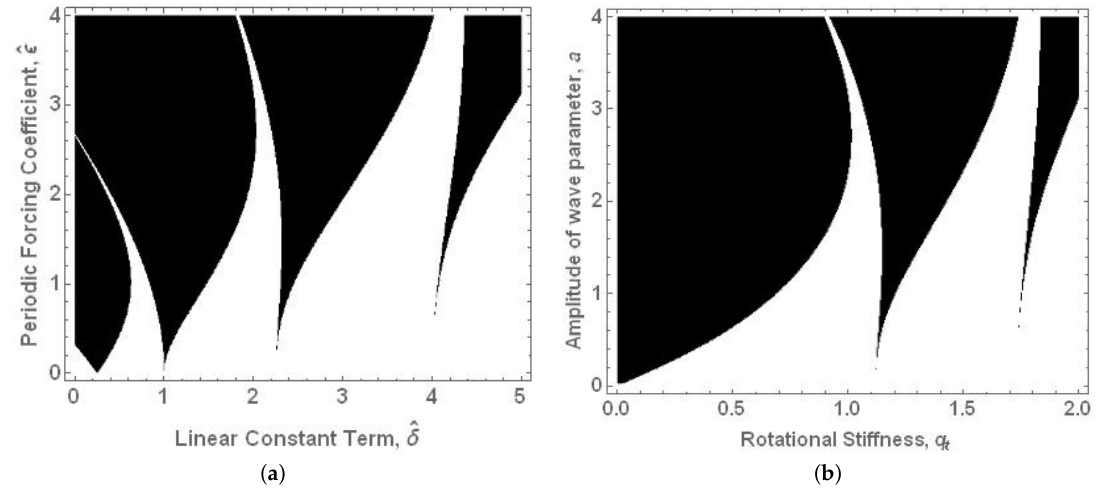
Figure 7. Stability plot for SSF with significant linear damping and without rotational damping ( a ) in ˆ δ − ˆ (cid:101) plane, ( b ) in a − q t